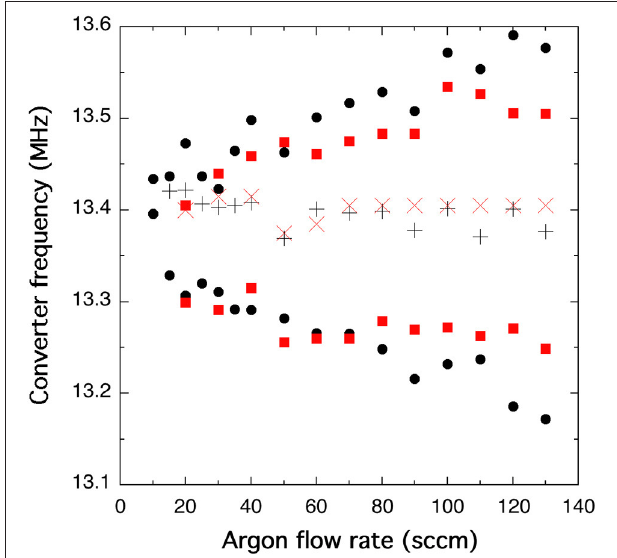
FIGURE 6 | Plenum pressure increase after 10 s of plasma as a function of power delivered to MiniPR using system (1): Converter operating at 13.16 MHz (filled black dots with P MiniPR ∼ 0.8 I conv V conv ) and system (2): MKS rf generator operating at 13.5 MHz (open red squares squares with P MiniPR ∼ 0.5 P mks ) for the IRUKANDJI atmospheric pressure test configuration of Figure 1 ; gas flow rate is 20 sccm.